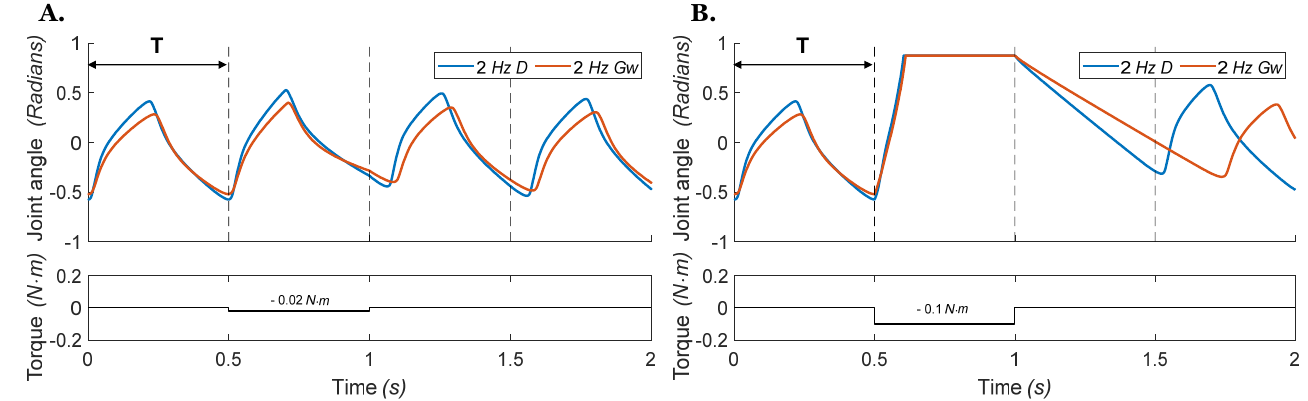
Figure 9. Hip joint angles vs. time during stepping with an external perturbation torque applied to the joint during ‘air-walking’ in which the leg does not touch the ground. The torque is applied on the femur at the start of the second stance phase at 0.5 s and ends at 1 s, with a duration of one step cycle. The blue 2 Hz D line indicates that the CPG is operating at 2 Hz and driven by the direct stimulus D . The red 2 Hz G w line indicates that the CPG is operating at 2 Hz by neuromodulation of the weak excitatory synapse conductivity G w . Dashed lines indicate when the transition from extension to flexion would occur if there was no perturbation. ( A ) Given a small torque perturbation ( − 0.02 Nm), both models recover after the perturbation ends. ( B ) A large torque perturbation ( − 0.1 Nm) causes the deletion of an entire step cycle.